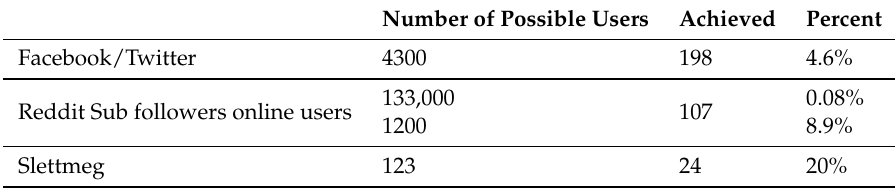
Table 2. Table showing answer rate with how many possible respondents there were on the platforms.